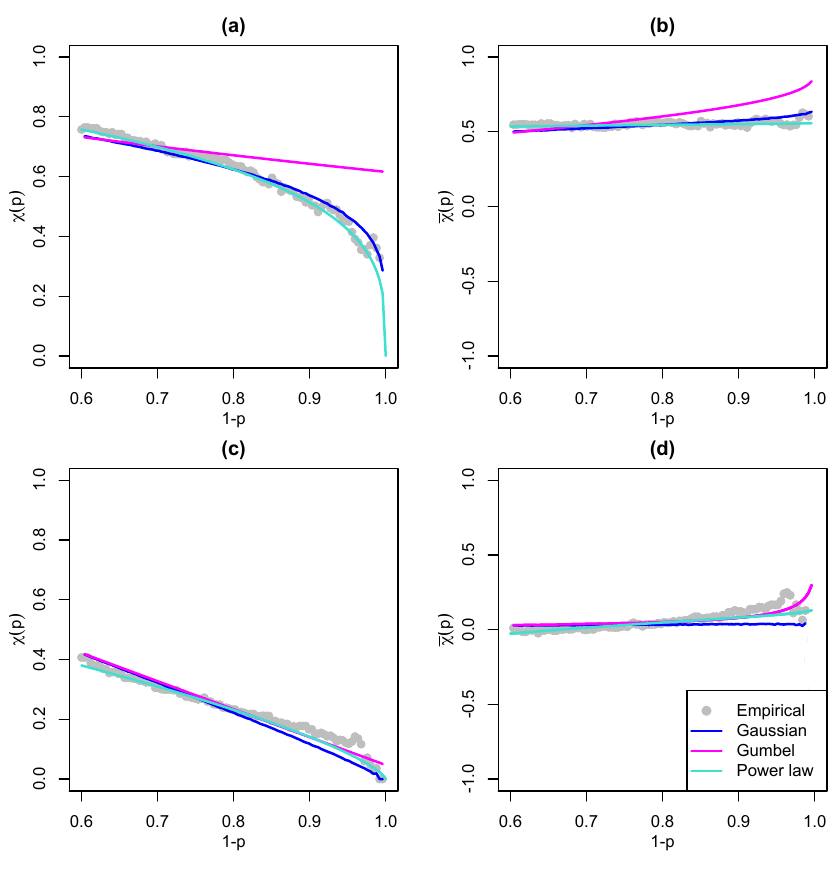
Figure 4. Extremal dependence measure χ(p) , for p ∈ [ 0 , 0 . 4 ] , for windstorm footprint wind gust speeds in London paired with (a) Am- sterdam and (c) Madrid, and dependence measure χ(p) , for p ∈ [ 0 , 0 . 4 ] , for windstorm footprint wind gust speeds in London paired with (b) Amsterdam and (d) Madrid, calculated empirically and based on the Gaussian, Gumbel, and power law bivariate dependence functions, as defined in Table